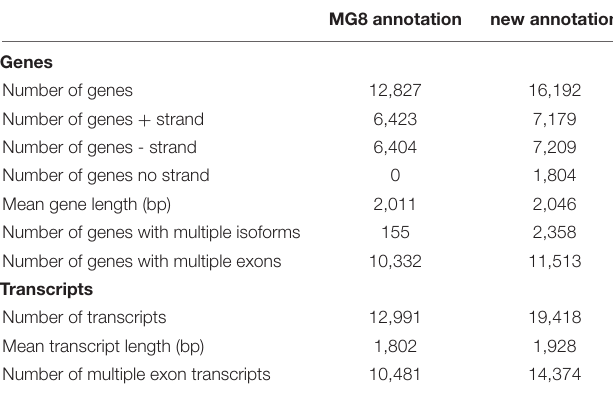
TABLE 1 | Comparison between newly built annotation and the MG8